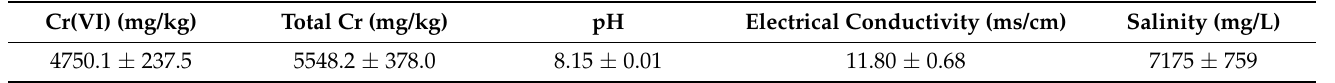
Table 1. Physicochemical characteristics of Cr-contaminated soil presented as the means ± standard deviations (SDs); n =